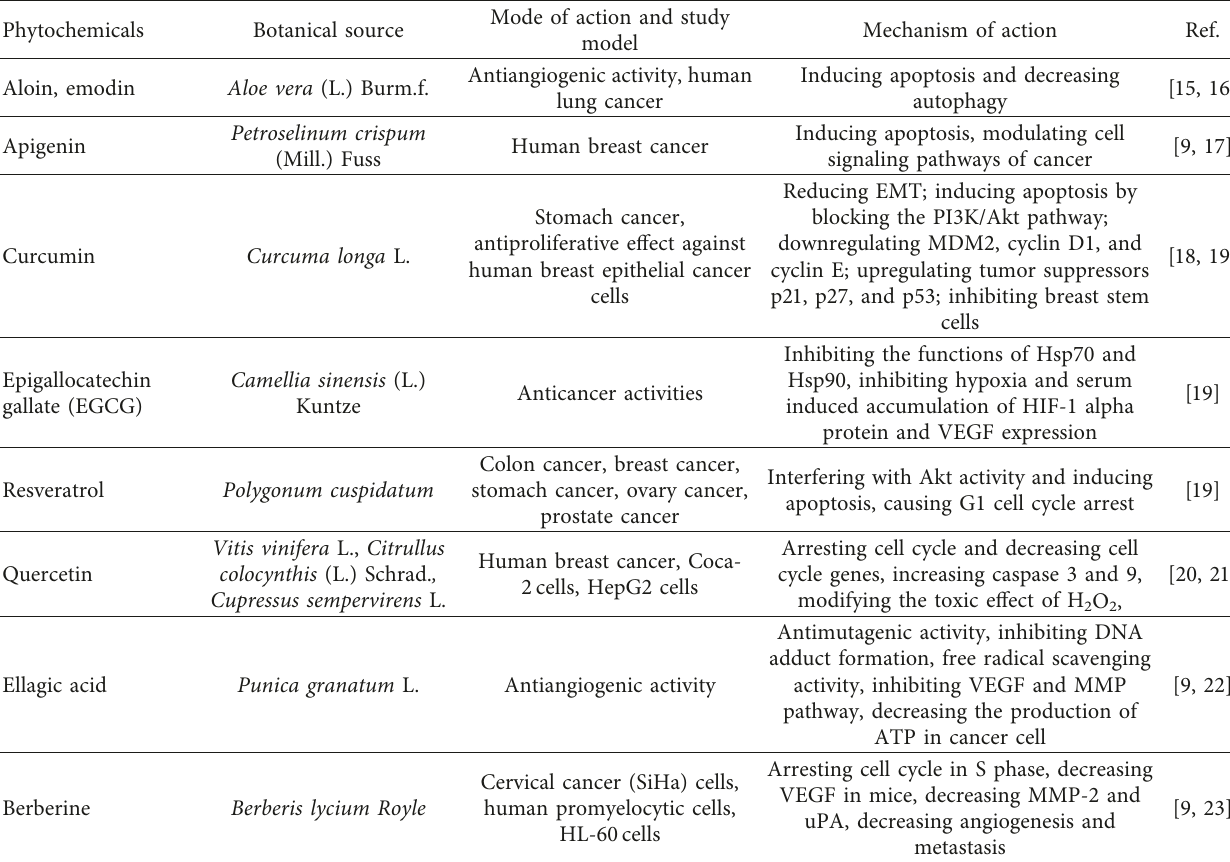
Table 1: List of some important anticancer phytochemicals, their botanical sources, and underlying anticancer mechanisms.